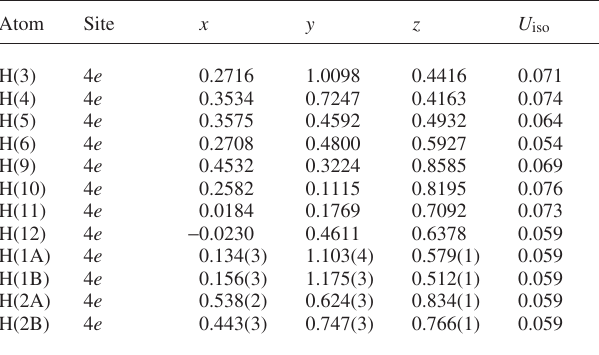
Table 2. Atomic coordinates and displacement parameters (in Å 2 )